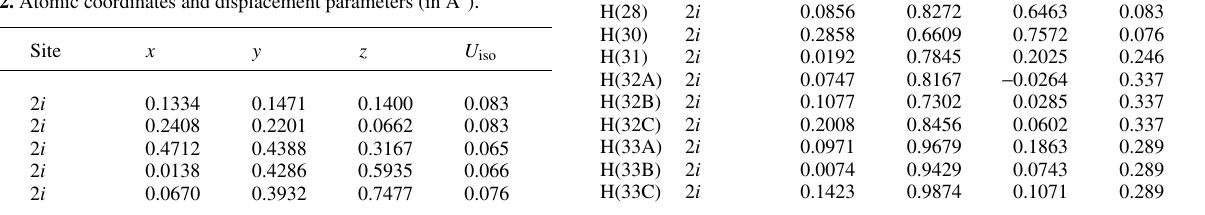
Table 2. Atomic coordinates and displacement parameters (in Å 2 ) .